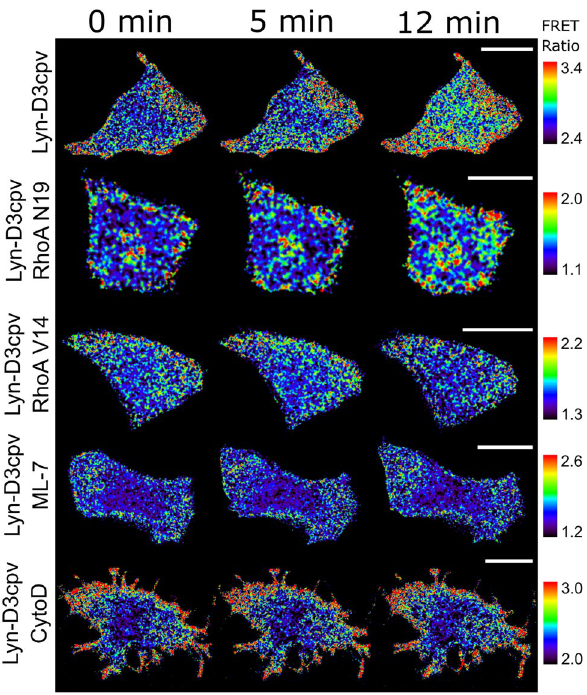
Figure 5. Time-lapse fluorescence resonance energy transfer (FRET) ratio images of the Michigan Cancer Foundation-7 cells in false colors. Naltriben was added 5 min after the beginning of the experiment. The colored scale bar represents the range of the biosensor FRET/enhanced cyan fluorescent protein (CFP) emission ratios. The warmer the color of the pixel, the higher the Ca 2+ concentration reported. Chemical pretreatment or RhoA mutant vector co-transfection lowered TRPM7-induced Ca 2+ influx, hence, diminished the FRET/CFP ratio signal change. CytoD, cytochalasin-D. Scale bar = 20